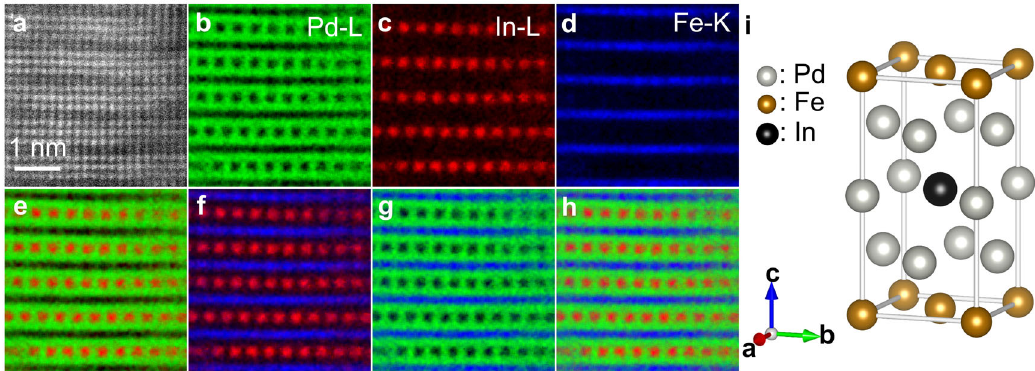
Fig. 2 Direct observation of In atoms in Z 3-type structure. a – d , HAADF-STEM image ( a ) and the elemental maps (Pd-L ( b ), In-L ( c ) and Fe-K ( d )) of Z 3-type structure. e – h , Overlay of b and c ( e ), c and d ( f ), b and d ( g ), and b – d ( h ). i , Unit cell of Z 3-Fe(Pd,In d )